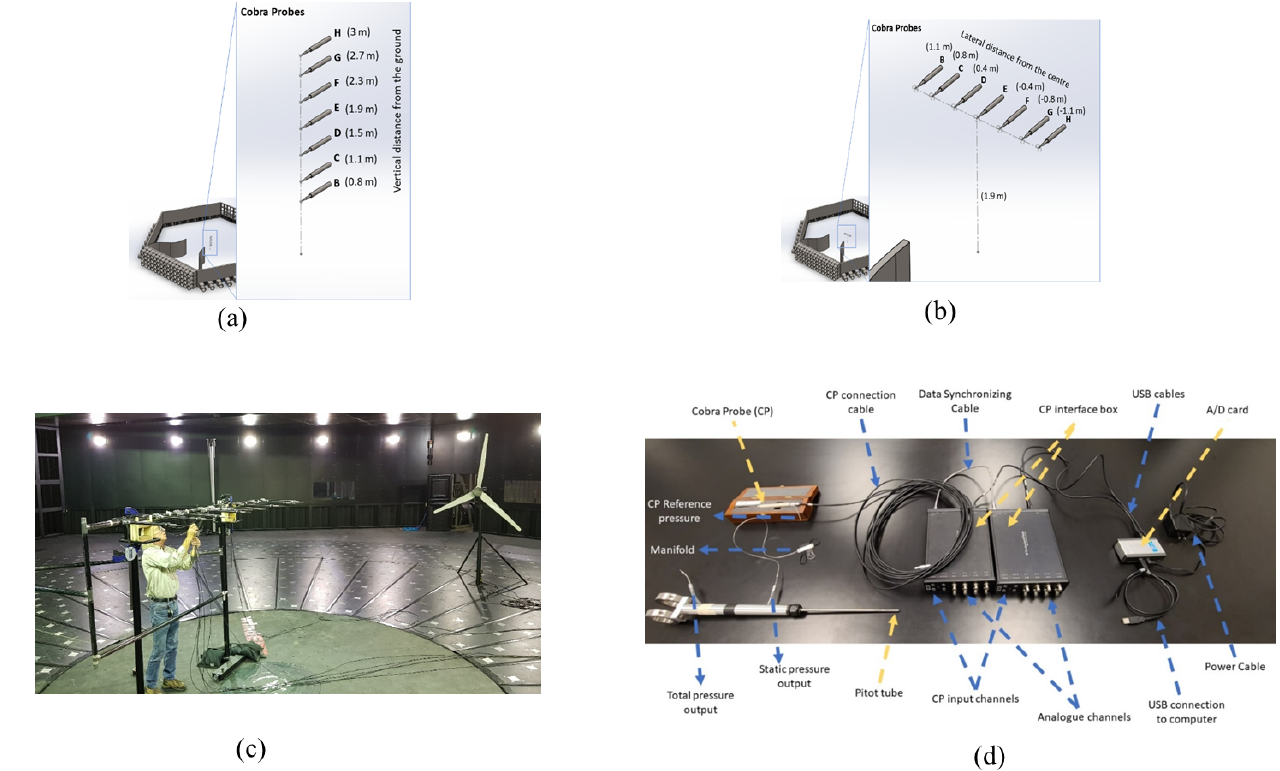
Figure 6. The arrangement of cobra probes based on the dimension of a 2.2m diameter HAWT for (a) vertical and (b) horizontal measure- ments at the centre of the test section. (c) Setting up the seven cobra probes in a horizontal arrangement at the test section. (d) Cobra probe connection